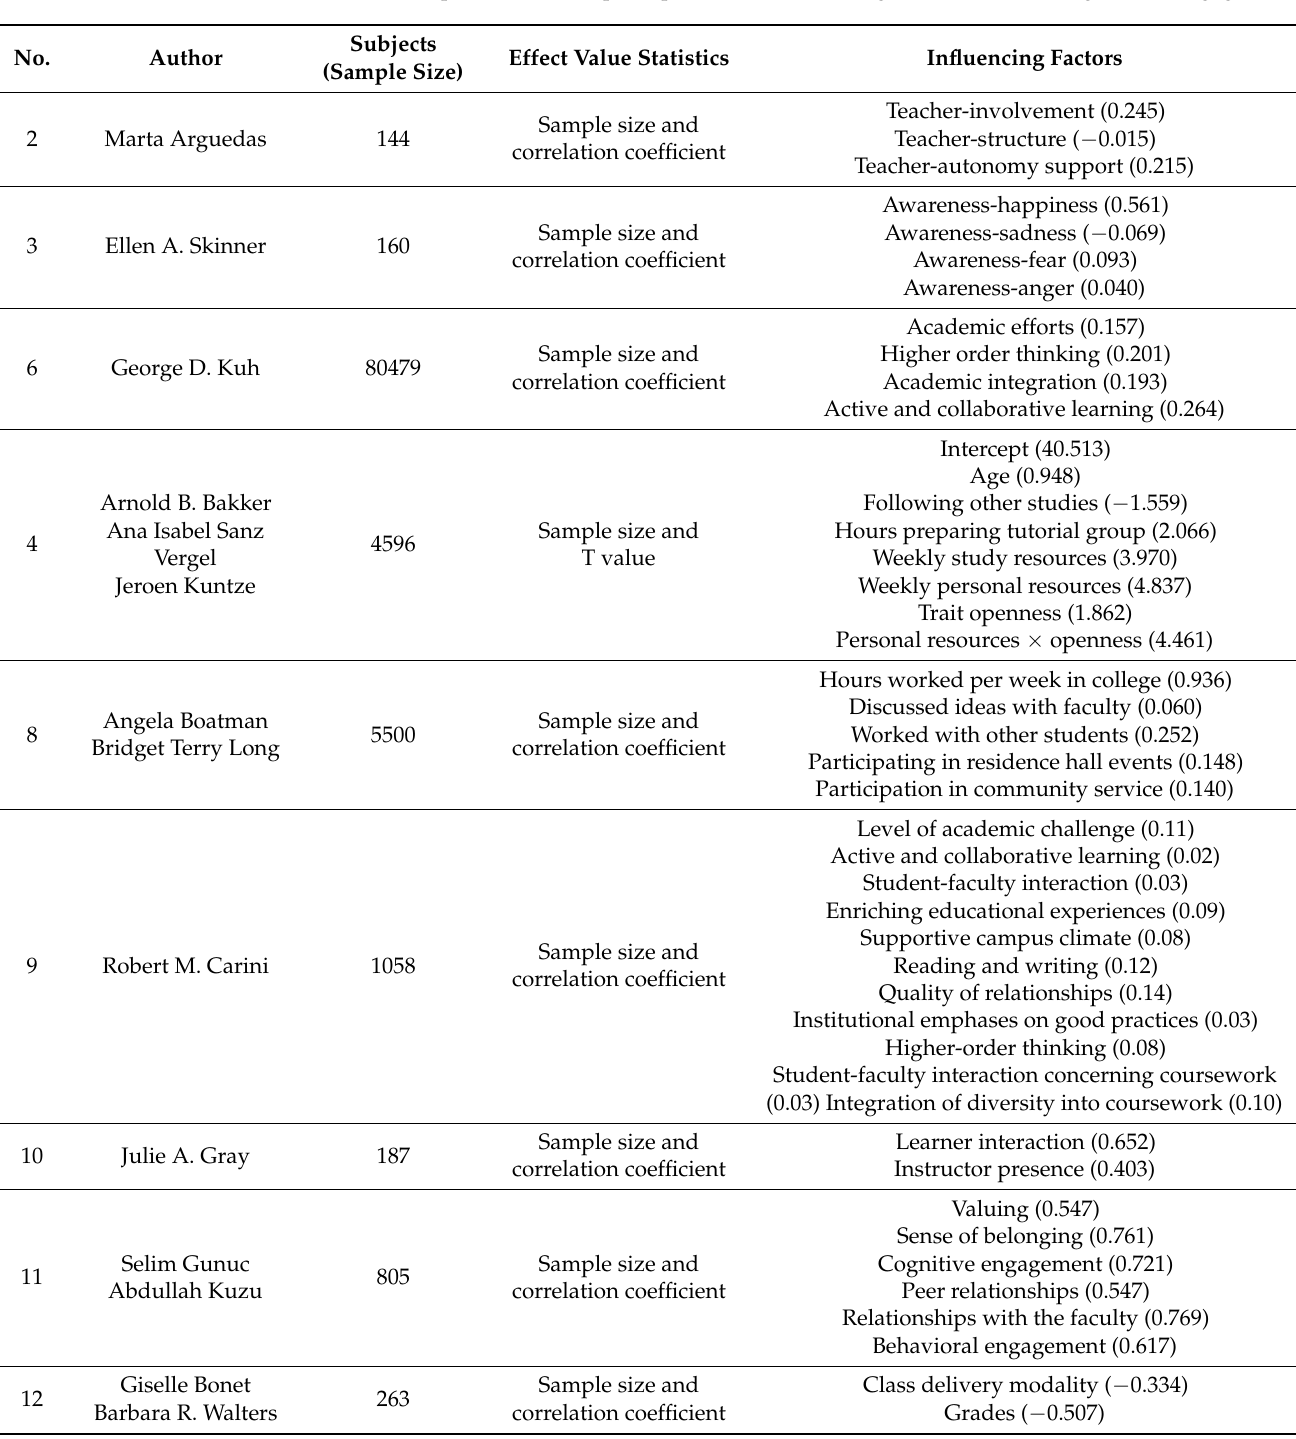
Table 1. A representative sample of partial literature coding of factors influencing student